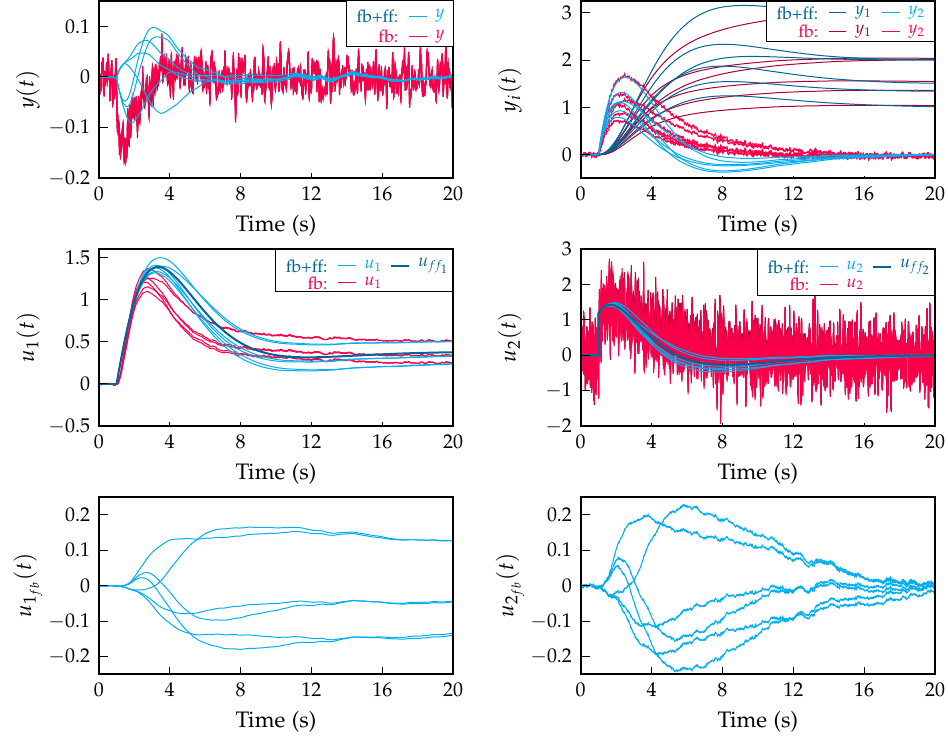
Figure 6. Time-domain